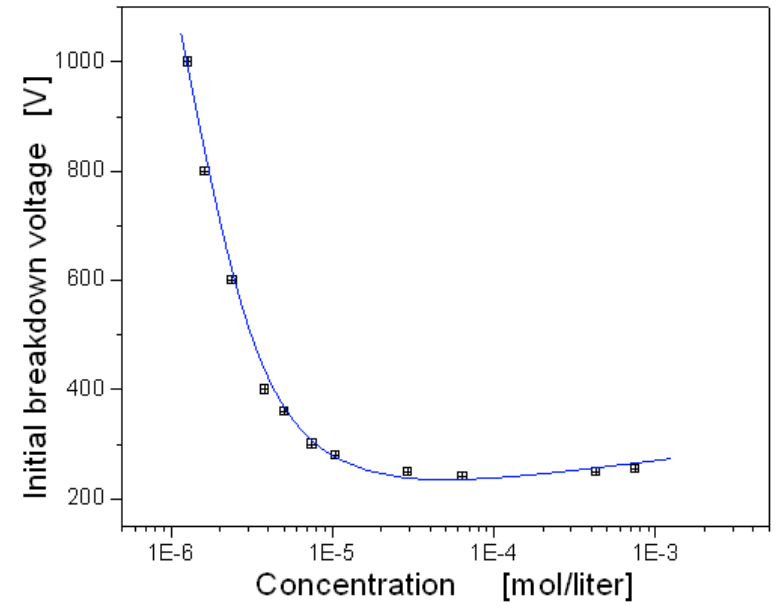
Figure 8. Dependence of initial breakdown voltage on Ar